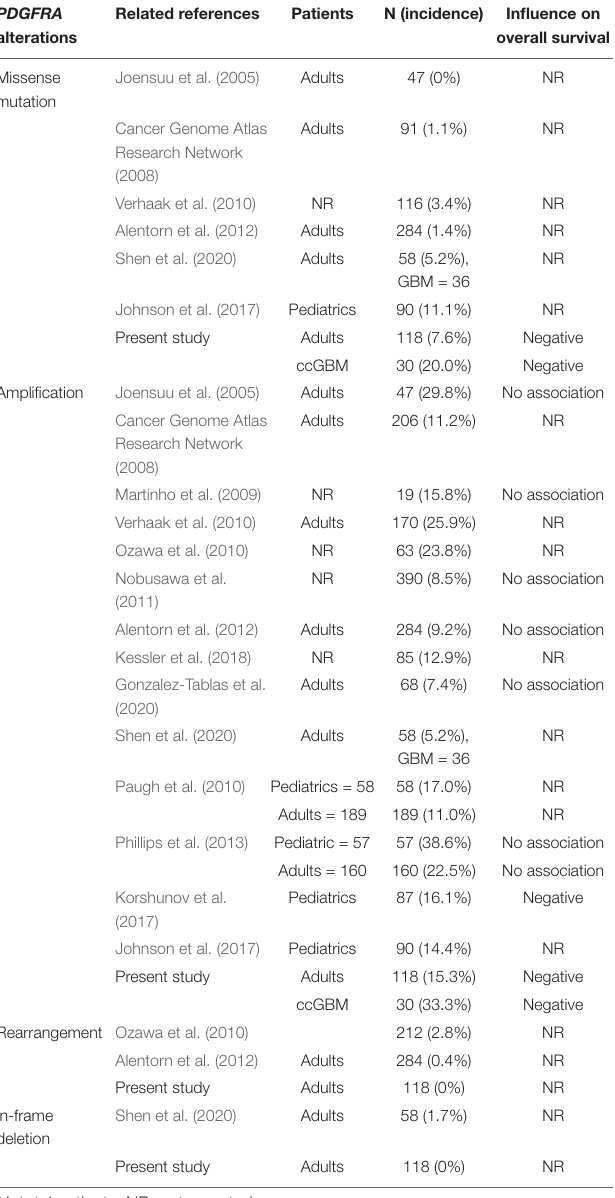
TABLE 8 | Summary of studies on patients with GBM of PDGFRA